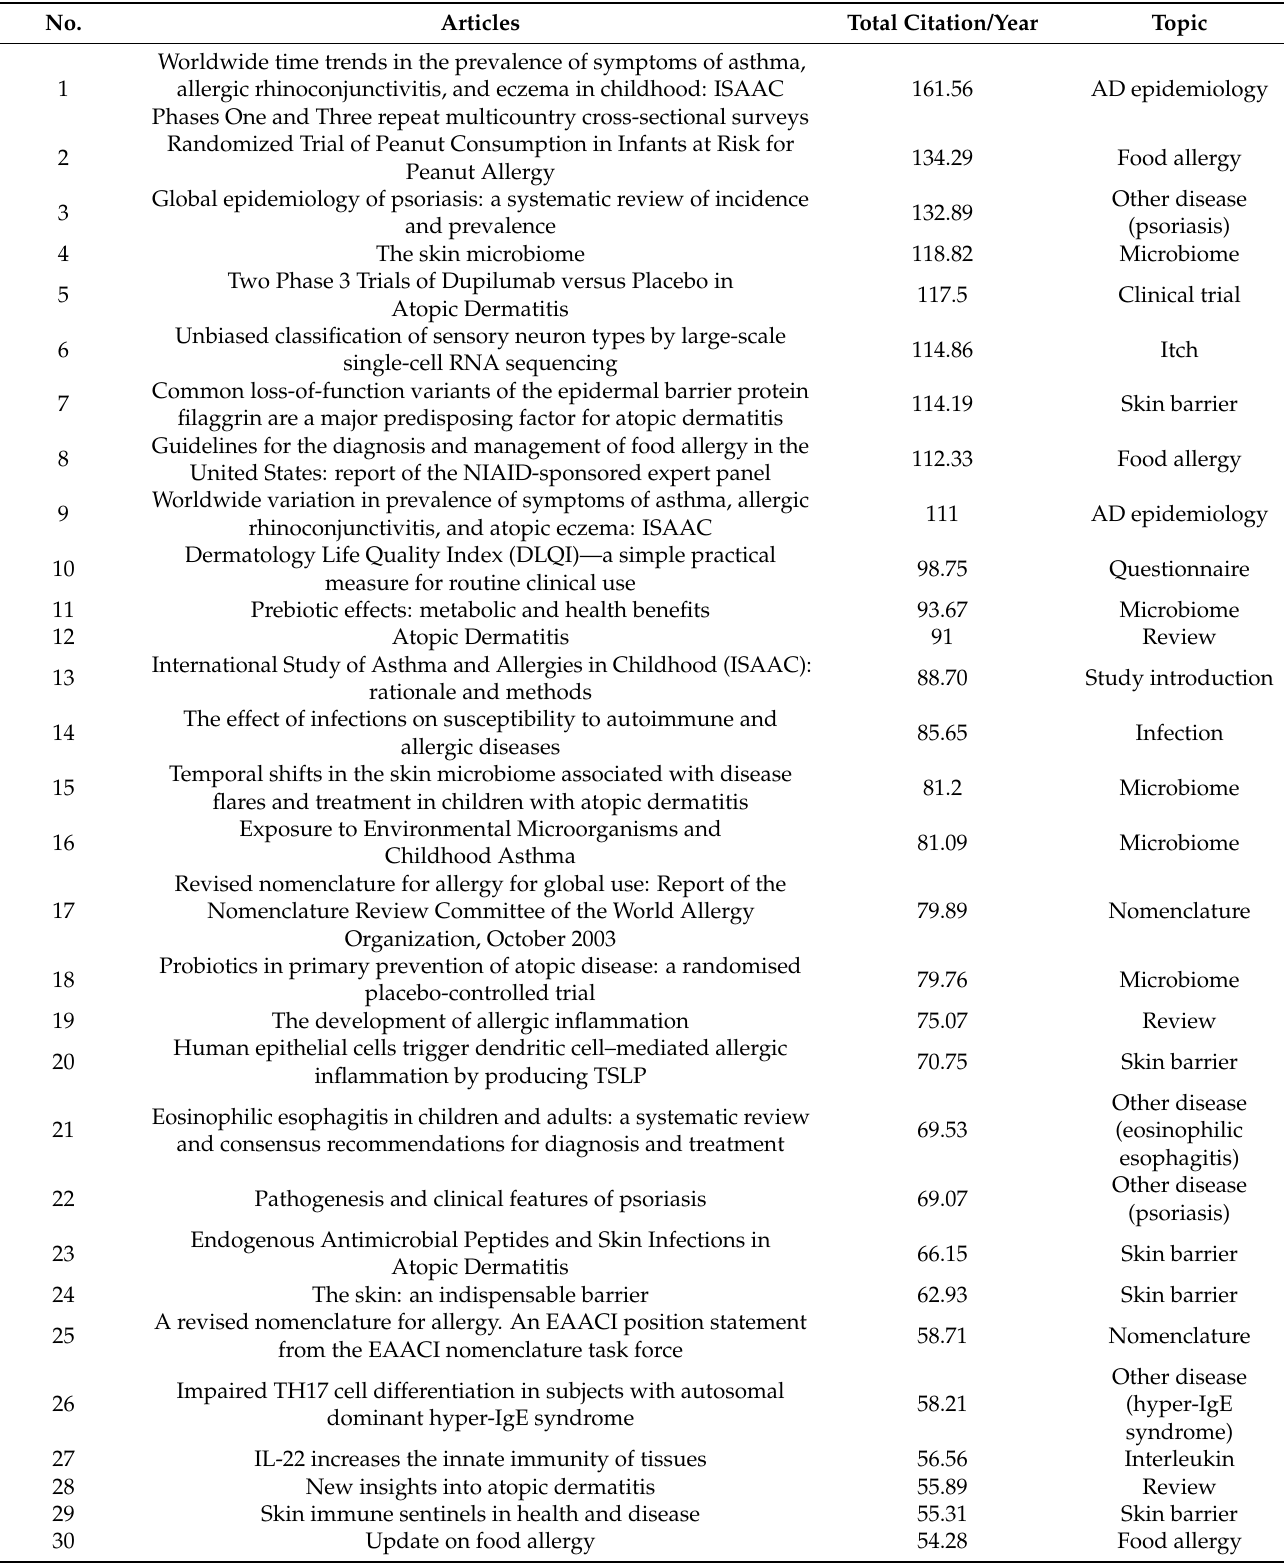
Table 1. The top 30 most cited papers on atopic dermatitis over the past 30